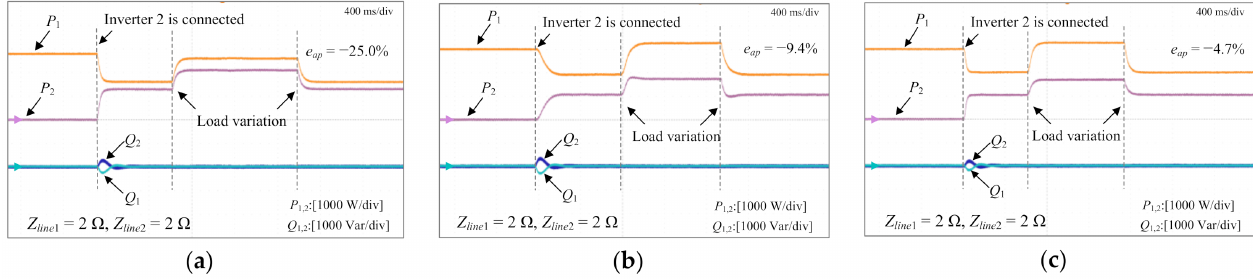
Figure 17. Experimental results of power responses as power capacity ratio of inverter 1 and inverter 2 to be 2:1: ( a )power sharing performance via conventional P-U/Q-f droop control method; ( b ) power sharing performance via PI-based P-U/Q-f droop control method; ( c ) power sharing performance via proposed TSMC-based P-U/Q-f droop control method.